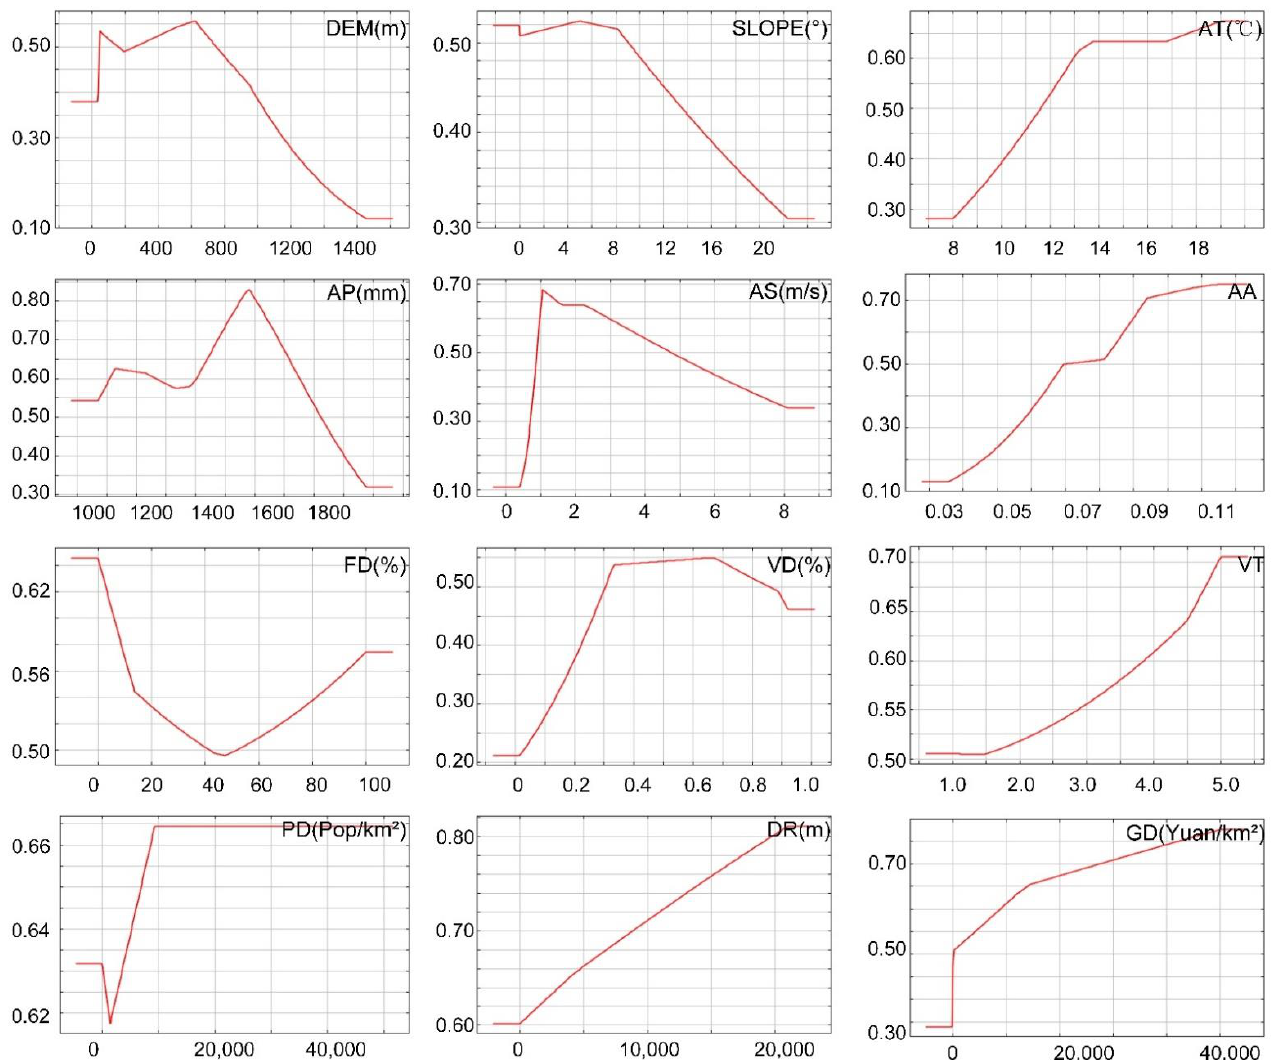
Figure 5. Response curves of environmental variables for wildfire.